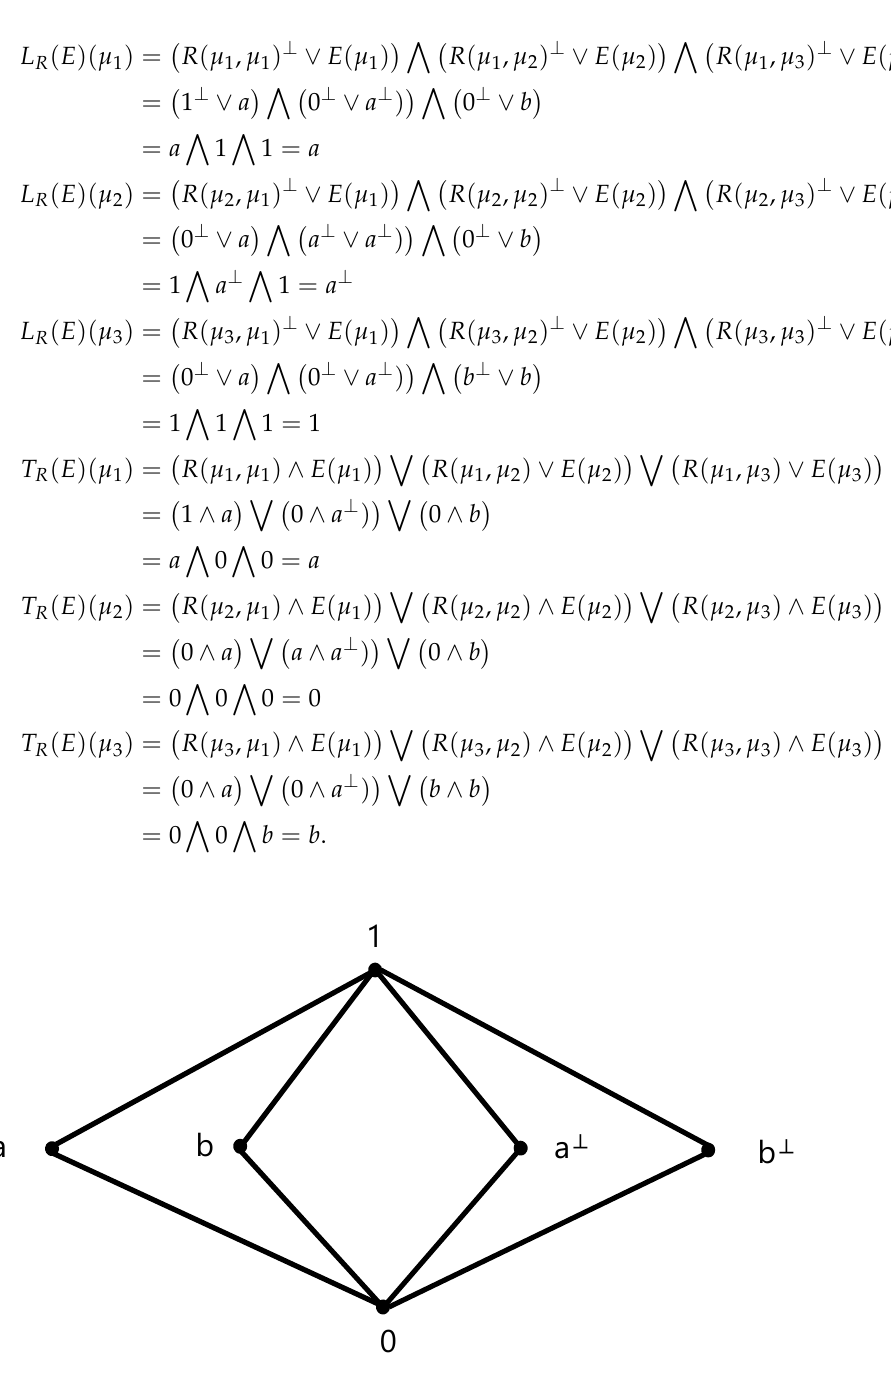
Figure 1. Orthomodular lattice MO 2 [49]. Table 1. The L -valued relation R in Example